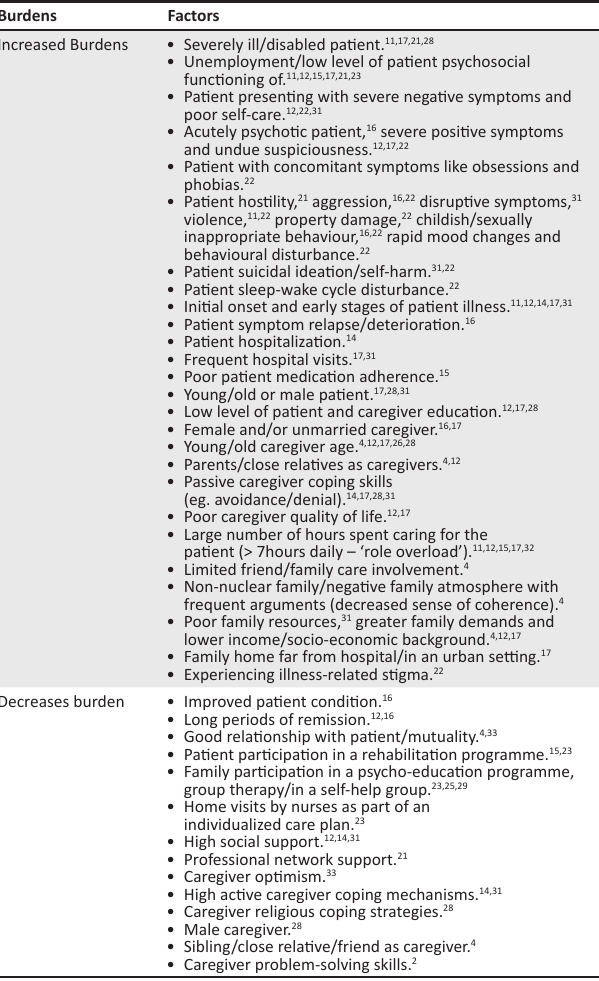
TABLE 2: Factors influencing burden. Burdens Factors Increased